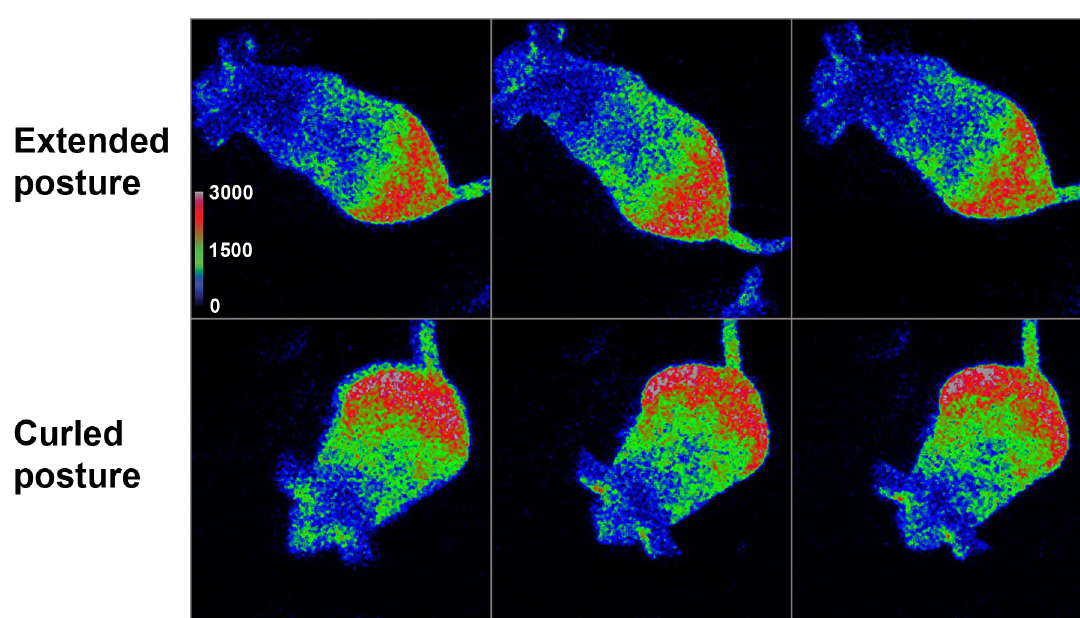
Fig 2. Luciferin assimilated by drinking enables long-term bioluminescence imaging. Shown is a female non-anesthetized, freely moving Hr-Per1 mouse imaged after oral luciferin delivery (1 mM luciferin in apple juice). Frames were captured with 0.5 second exposures within a 15-min imaging sequence and selected by eye according to body shape contours. Top row: in the extended posture. Bottom: curled posture. The intensity range is in ADUs with 20x EM